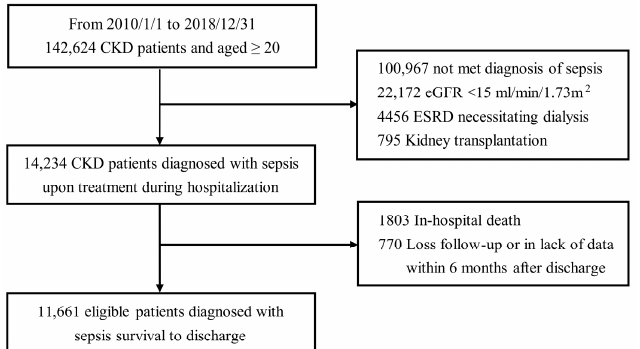
Figure 1. Study flowchart. This retrospective cohort consisted of 142,624 adults who received a diag- nosis of chronic kidney disease between 2010 and 2018—a total of 14,234 patients with concomitant sepsis were treated in the hospital. After excluding patients who died during admission and those with insufficient data, we finally enrolled 11,661 patients who survived sepsis to discharge. Abbrevia- tions: CKD—chronic kidney disease; eGFR—estimated glomerular filtration rate; ESRD—end-stage renal